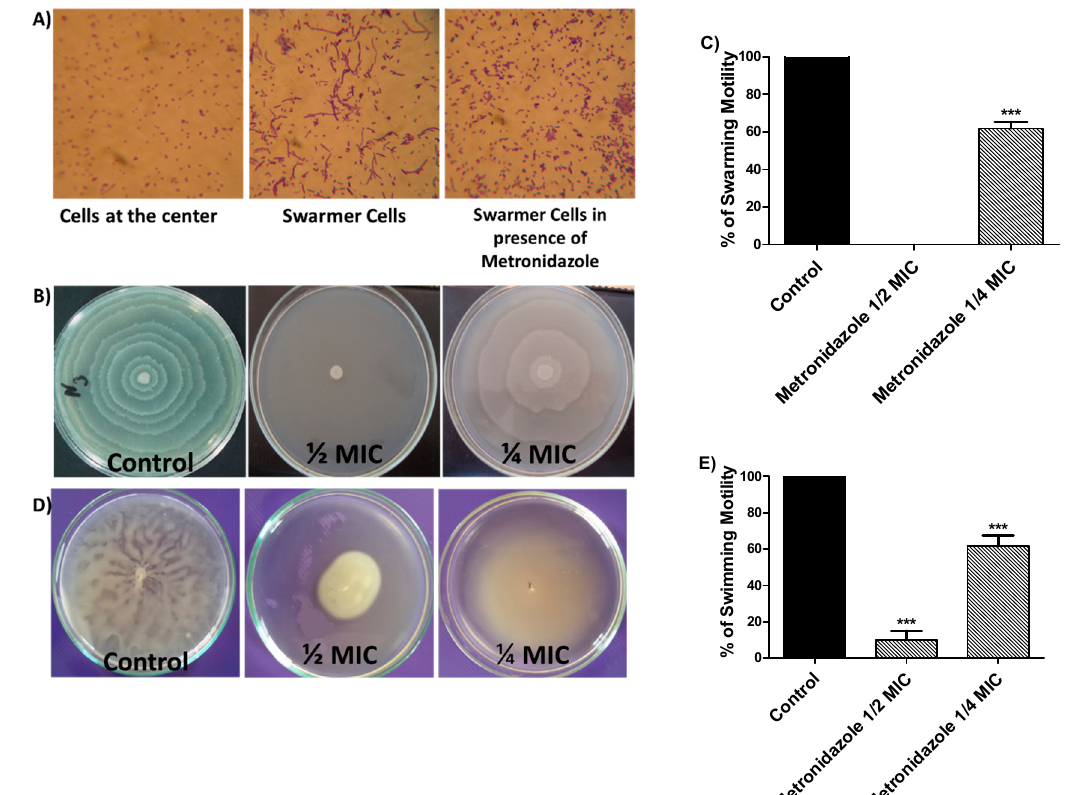
Figure 3. Effect of metronidazole in sub-MIC on P. mirabilis motility. One-way ANOVA test was used to compare between the metronidazole in ½ MIC or ¼ MIC treated and untreated bacterial cultures. The data were shown as mean ± standard error of percentage change from untreated cultures; and were considered statistically significant when p values < 0.05. ( A ) Light microscope image of simple stained P. mirabilis at the center (non-swarmer cells), the edge of swarming (elongated larger swarmer cells) and swarmer cells in precence of metronidazole. Clearly, the swarmer cells in precence of metronidazole is smaller than those in absence of metronidazole. ( B , C ) Metronidazole in sub-MIC significantly reduced the swarming motility ( p < 0.0001). ( D , E ) The diameters of swimming motiliy were significantly decreased in precence of meetonidazole in sub-MIC ( p < 0.0001). *** = p < 0.001.